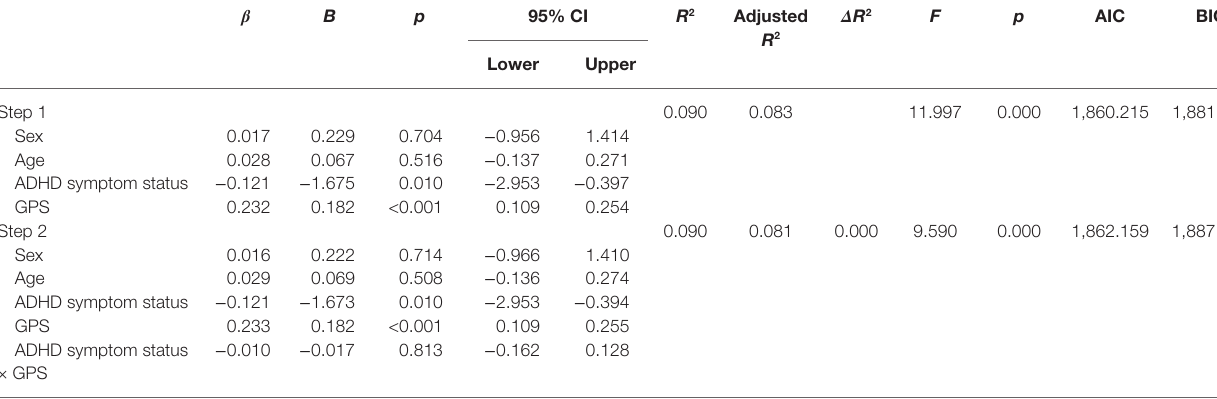
TABLE 3 | Attention-deficit hyperactivity disorder symptom status, procrastination, and their interactions with